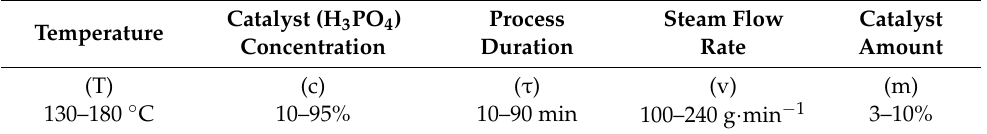
Table 1. The pre-treatment process parameter